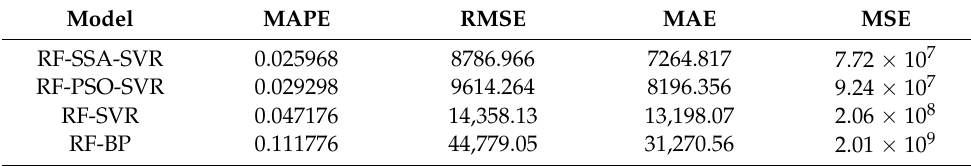
Table 3. Evaluation